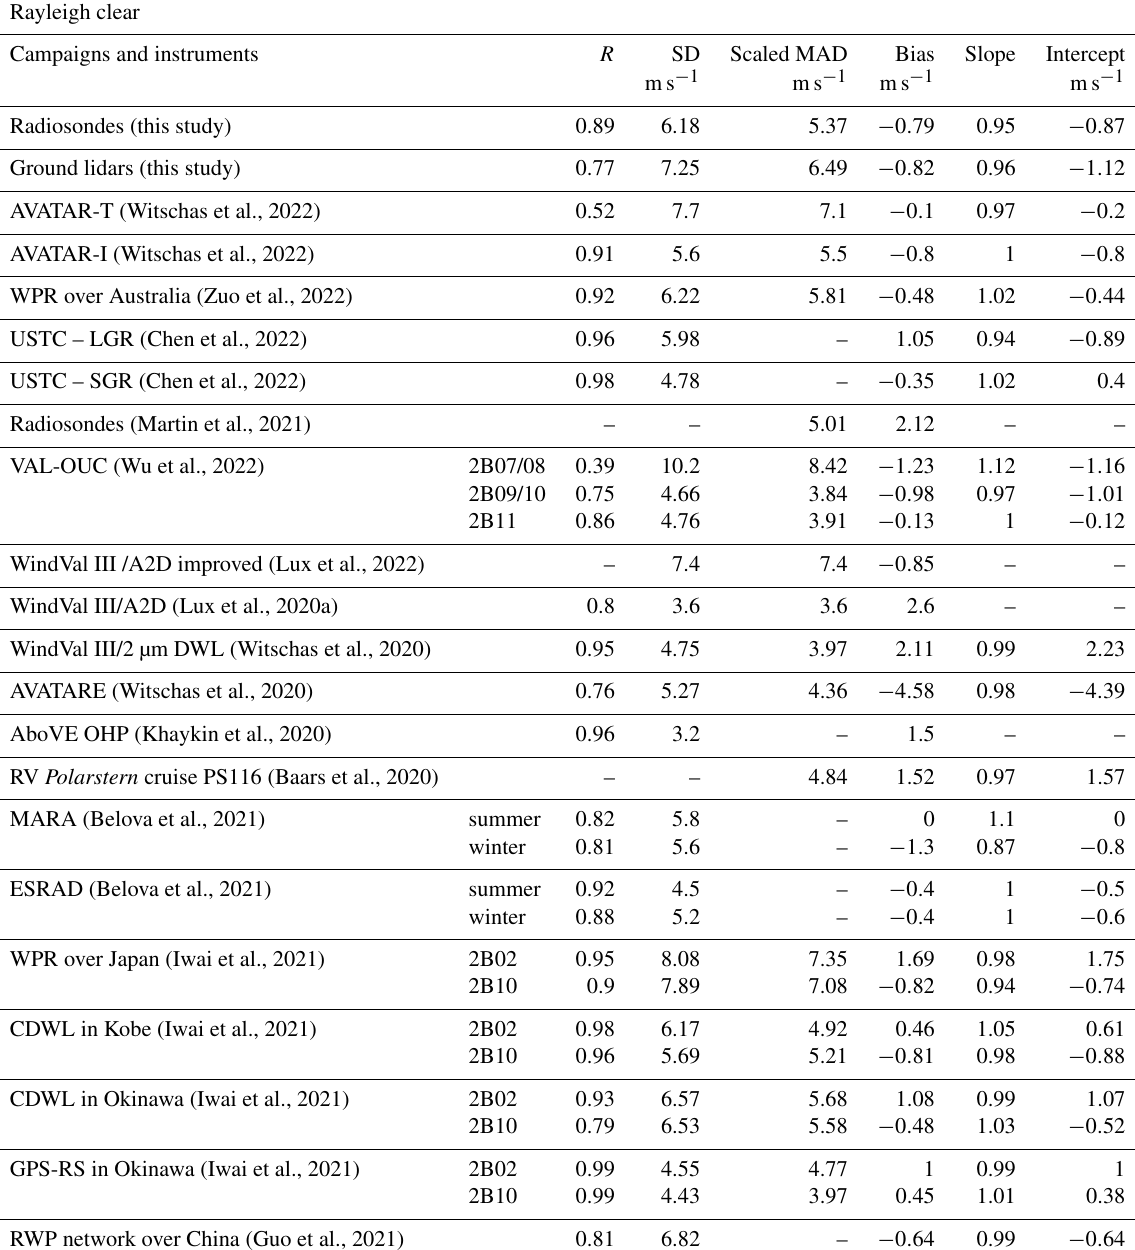
Table 7. Summary of the recent comparison campaign validation results, following Wu’s (2021) referencing convention. Rayleigh